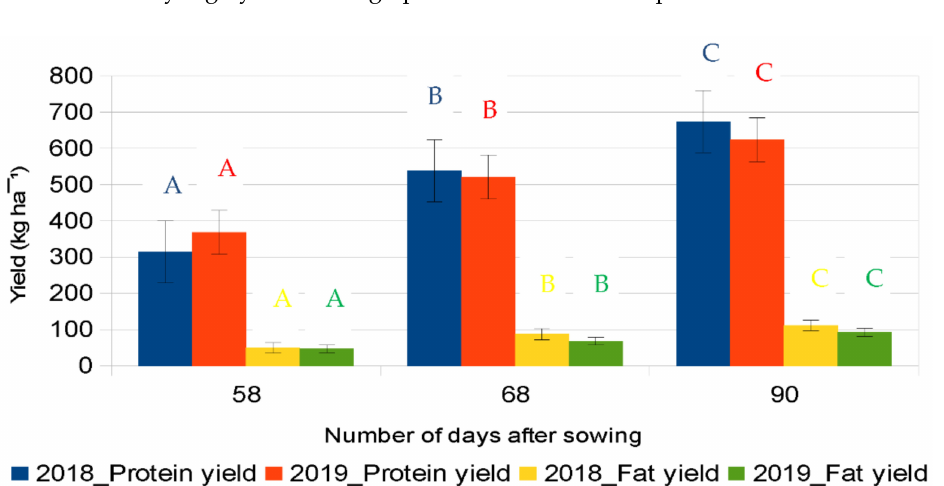
Figure 2. Protein yield and fat yield in relation to harvesting date. Significant differences marked with different colors of capital letters indicate at p ≤ 0.01—separately for years 2018 and